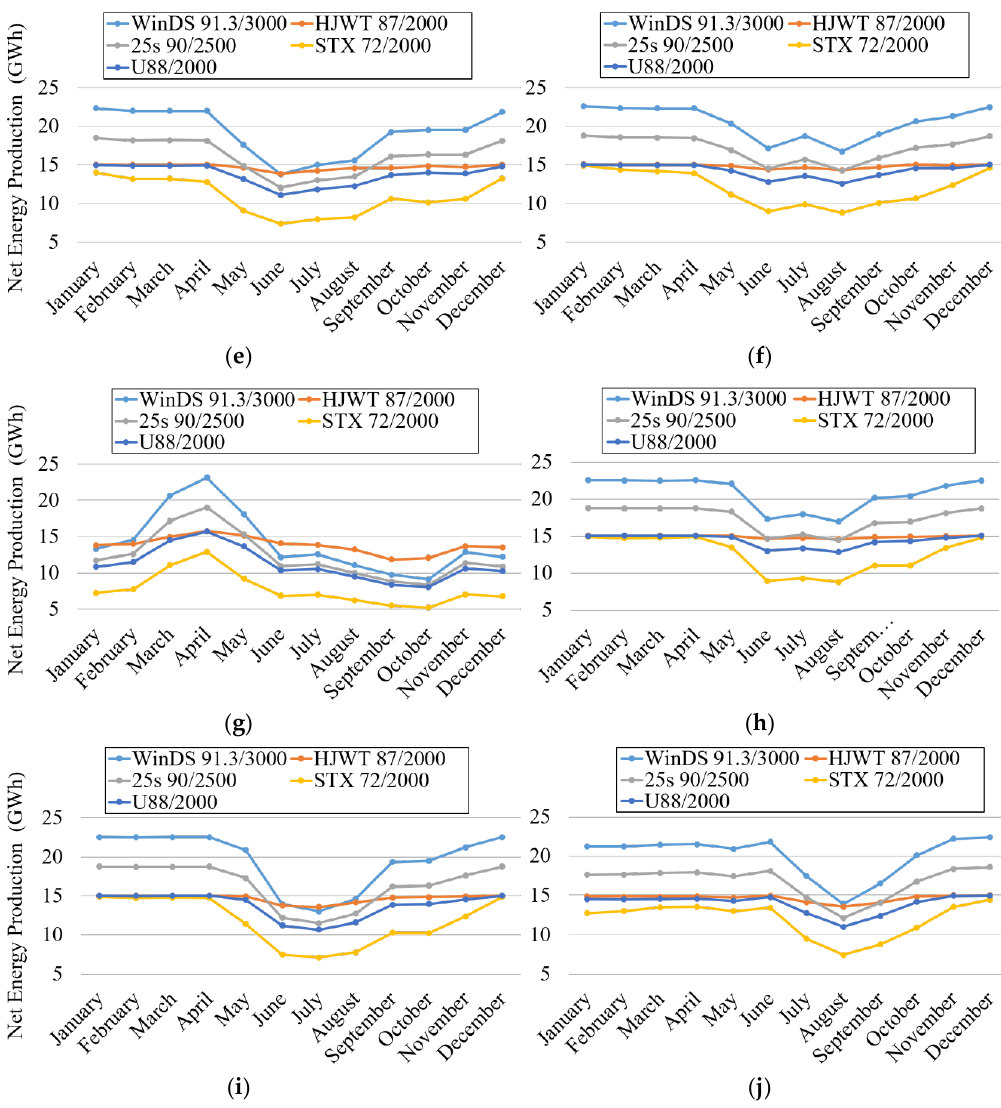
Figure 11. Estimation of net AEP at newly proposed wind farm sites ( a ) Site 1 ( b ) Site 2 ( c ) Site 3 ( d ) Site 4 ( e ) Site 5 ( f ) Site 6 ( g ) Site 7 ( h ) Site 8 ( i ) Site 9 ( j ) Site